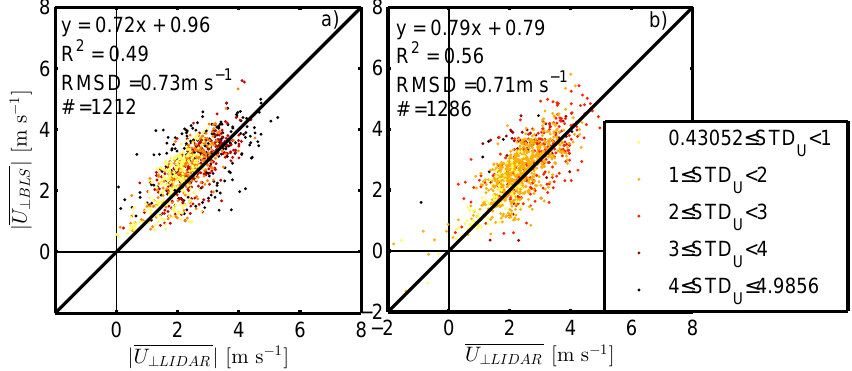
Figure 6. (a) Crosswind 10min averages estimated by the scintillometer ( U ⊥ BLS ) using the cumulative-spectrum method against Doppler lidar crosswind ( U ⊥ LIDAR ). (b) Crosswind estimated by the scintillometer using the look-up-table method against lidar data. Both plots are colour-coded with the lidar-derived path-weighted standard deviation of the crosswind along the 4.2km path (see legend). The one-to-one lines are shown in thick